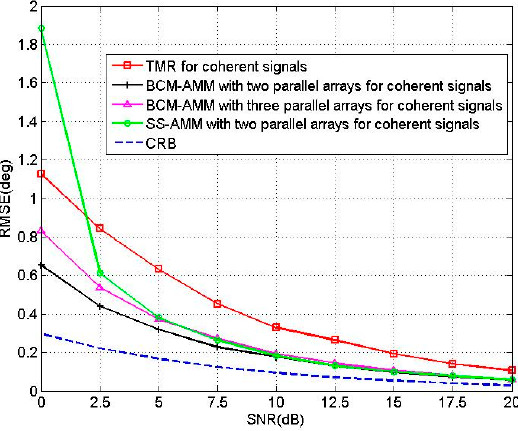
Figure 8. 2D DOA Estimation results of proposed BCM-AMM algorithm. ( a ) Three signals with different elevation and azimuth angles; ( b ) Two signals with the same azimuth angles.